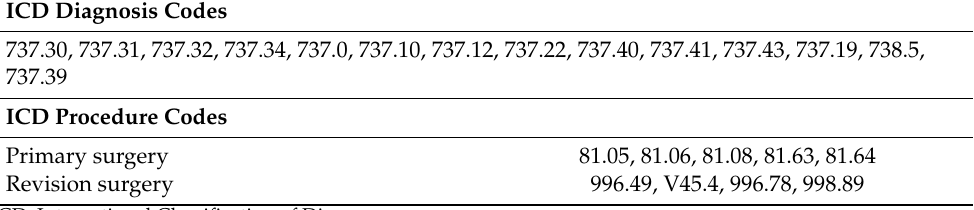
Table 1. List of all ICD diagnosis and procedure codes used for data extraction from the local spine